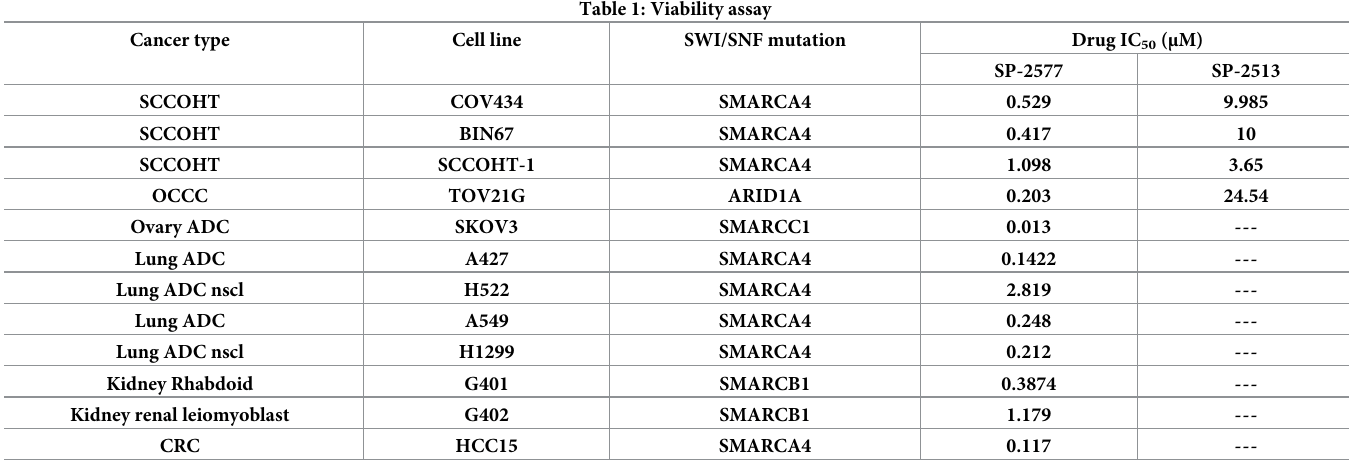
Table 1. Cytotoxicity of SP-2577 and SP-2513 in SWI/SNF-mutated cancer cell lines. Cell viability was evaluated after 72 h treatment with the drugs by Cell Titer Glow assay.